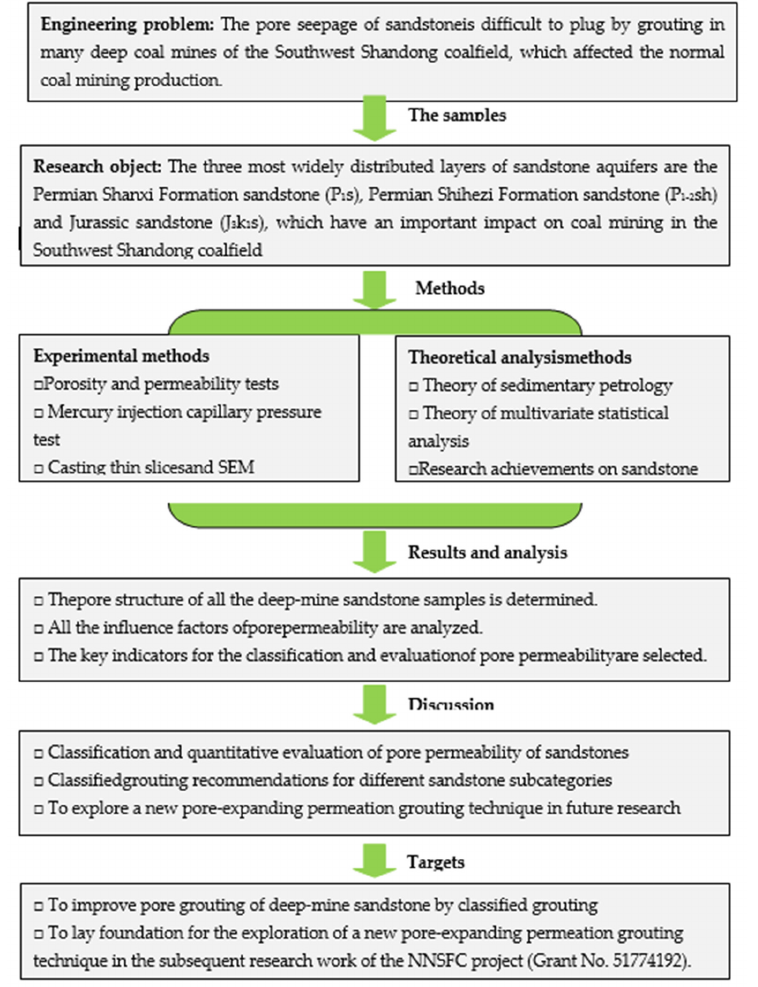
Figure A1. A general overview of the flow of this